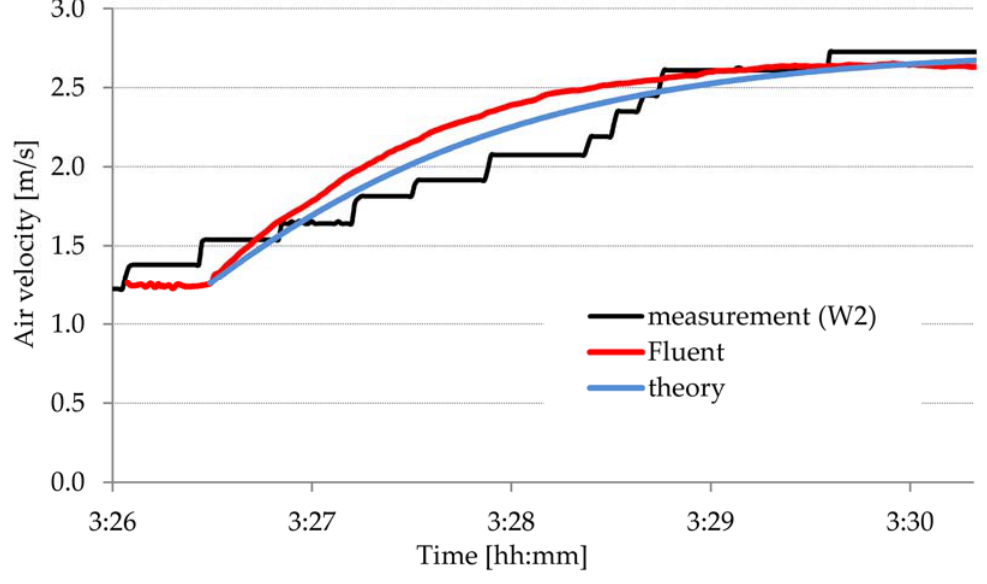
Figure 6. Transient case 1: “0” → “1 norm”.